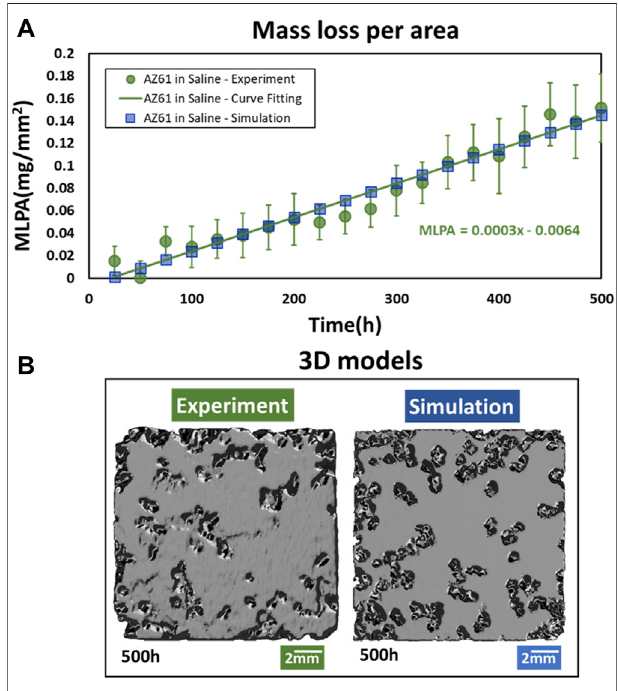
FIGURE 1 | Comparison of overall AZ61 corrosion in simulation and experiment. (A) Mass loss per area of experimental specimens and simulation model at different corrosion times. (B) 3D